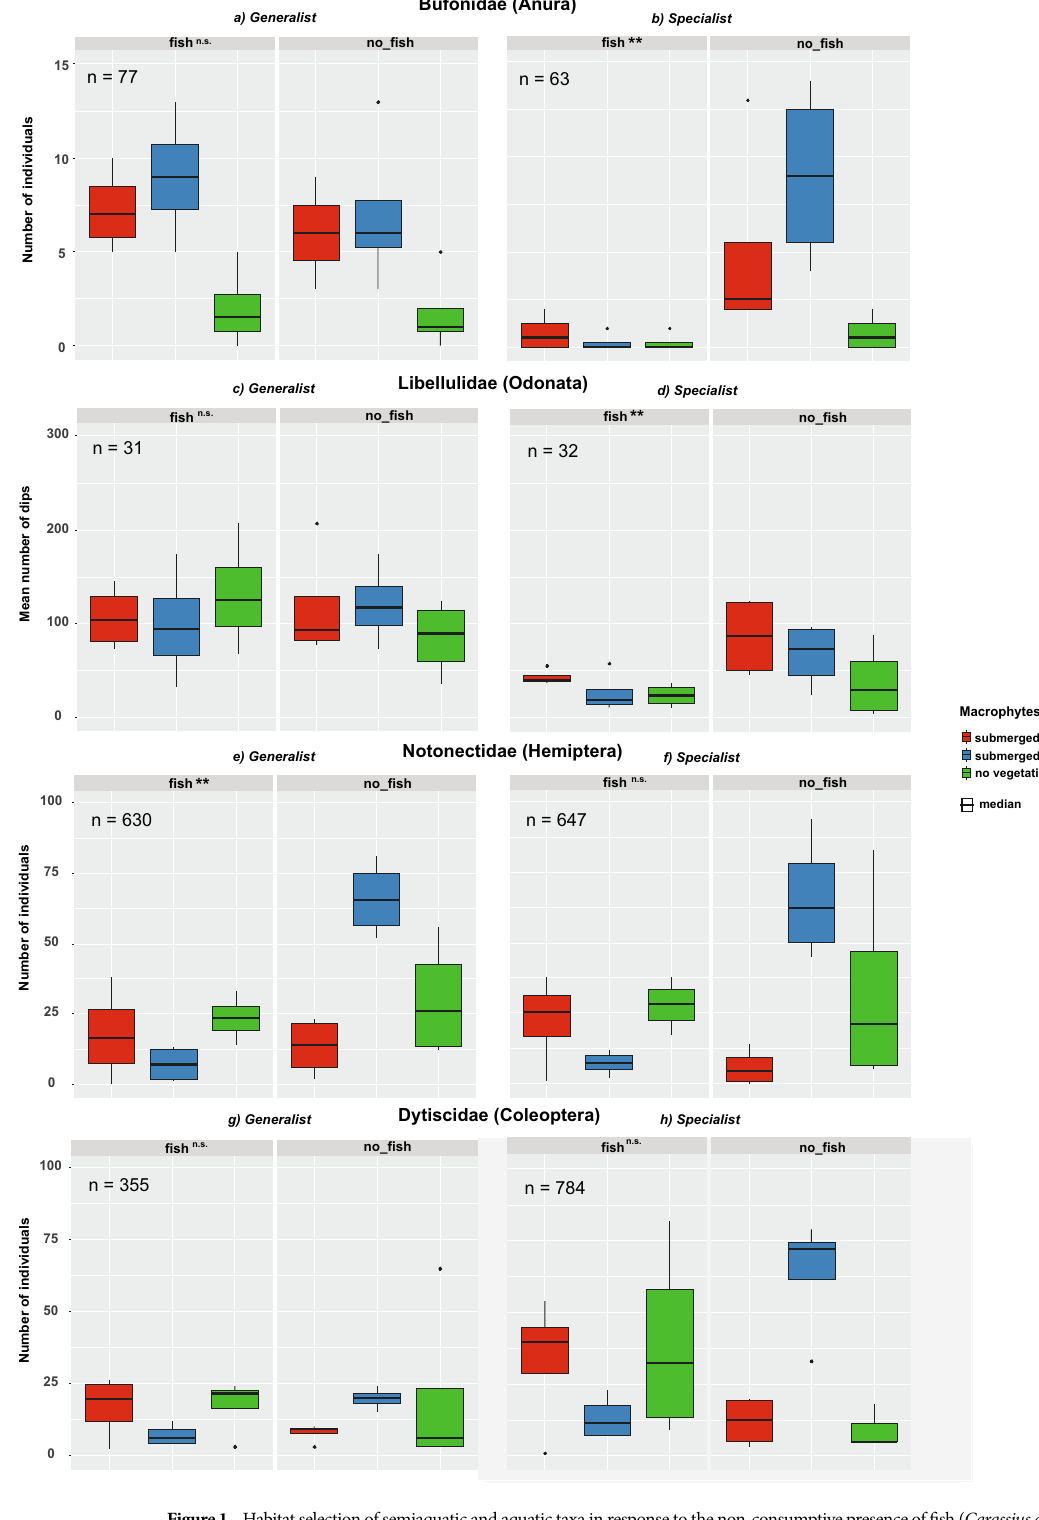
Figure 1. Habitat selection of semiaquatic and aquatic taxa in response to the non-consumptive presence of fish ( Carassius auratus ) and vegetation structure mimicking different successional stages of aquatic habitats. Effect of a fish (presence/absence) and vegetation structure (no macrophytes; submerged and floating macrophytes; submerged, floating, and littoral – emergent – macrophytes) on habitat selection by: ( a , b ) toads (Bufonidae); ( c , d ) odonates (Libellulidae); ( e , f ) true bugs (Notonectidae); and ( g , h ) diving beetles (Dytiscidae). ( a ) Bufo bufo , ( c ) Sympetrum sanguineum , ( e ) Notonecta glauca , and ( g ) Dytiscus marginalis represent habitat generalists, whereas ( b ) Bufotes viridis , ( d) Sympetrum danae , ( f ) Notonecta obliqua , and ( h ) Acilius sulcatus represent more sensitive habitat specialists naturally occurring in fishless environments. In toads, true bugs, and diving beetles, n represents the number of individuals included in the analysis. In odonates, habitat selection was measured as the number of oviposition dips performed by a female, and n denotes the number of tandem pairs used in the experiment. Levels of significance between treatments with and without fish are indicated: n.s. = not significant ( P > 0.05), ** = P ≤